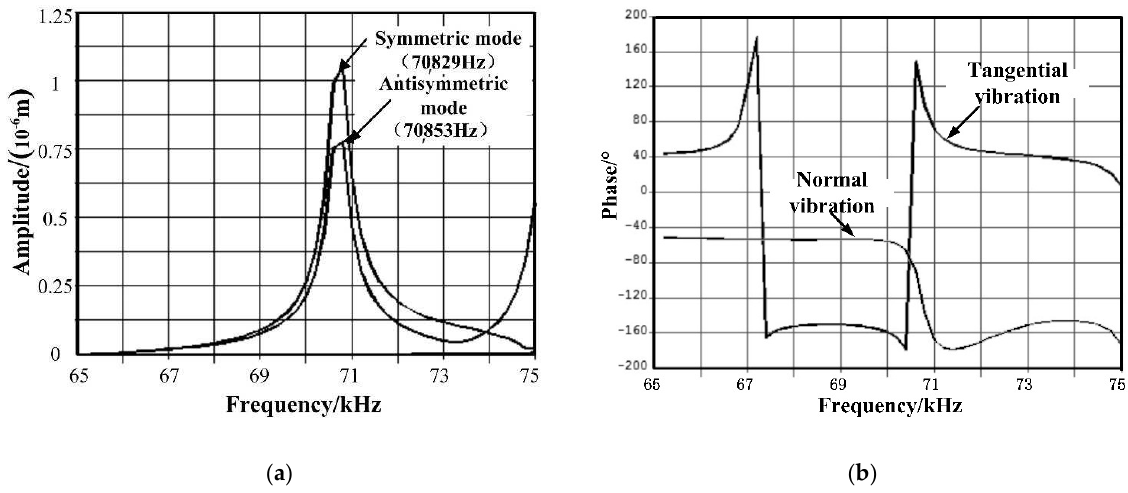
Figure 10. Harmonic response analysis of stator: ( a ) Amplitude frequency response; ( b ) Phase frequency response.